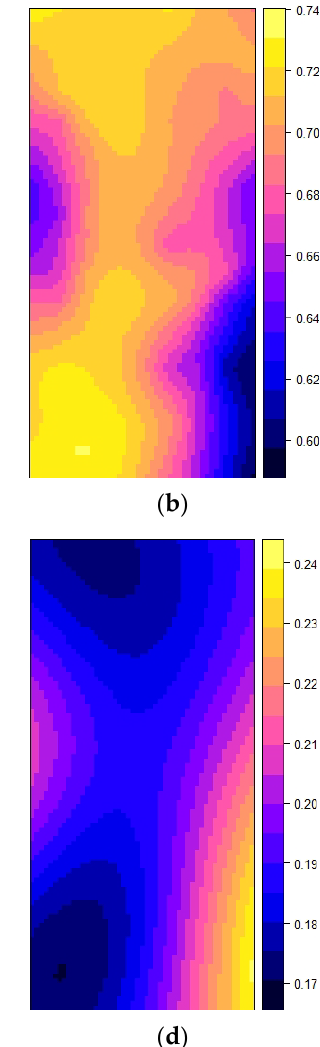
cross-correlation in the same spatial range was found for the two capacitive indicators, PMACe and ACe (Table